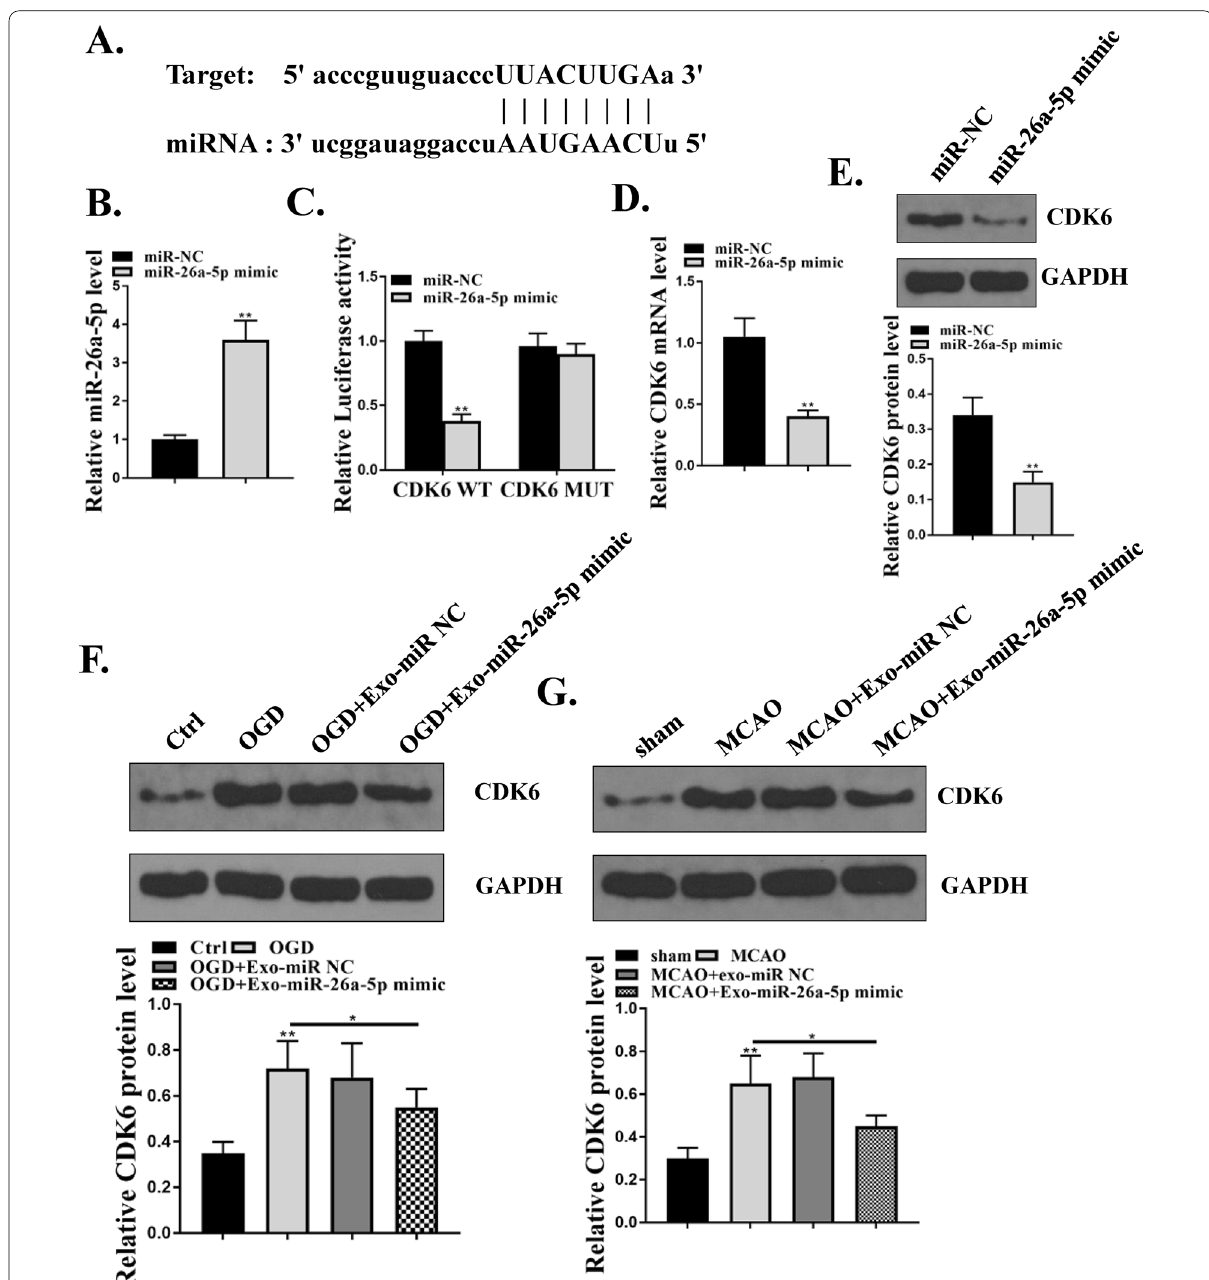
Fig. 5 The effect of miR-26a-5p was partially mediated by CDK6. A The putative binding site between miR-26a-5p and CDK6 was predicted by Targetscan. B 293 T cells were transfected with miR-26a-5p mimics or miR-NC, and the mRNA level of miR-26a-5p was detected by qRT-PCR. C 293 T cells were co-transfected with miR-26a-5p mimics or miR-NC and Luc-CDK6-WT or Luc-CDK6-MUT, and the relative luciferase reporter activity was evaluated by dual luciferase reporter system. D and E BV-2 cells were transfected with miR-26a-5p or miR-NC, and the expression of CDK6 was detected by qRT-PCR ( D ) and western blot ( E ). F BV-2 cells were treated by OGD/R, and then treated with 200 μg/mL Exo-miR-26a-5p mimics or Exo-miR-NC, and the protein level of CDK6 was evaluated by western blot. G Mice were induced by MCAO/R, and then injected with 200 μL/mice Exo-miR-NC or Exo-miR-26a-5p mimics. The protein level of CDK6 in brain tissues was detected by western blot. *p < 0.05 **p <